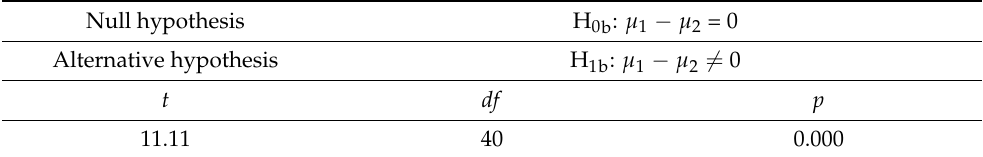
Table 25. Two-sample t -test for cutting ability experiment.